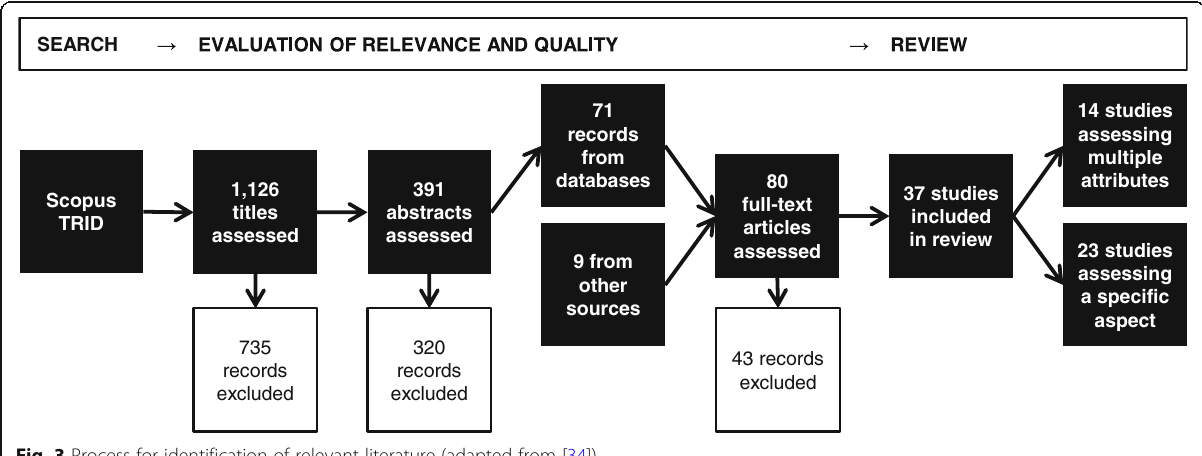
Fig. 3 Process for identification of relevant literature (adapted from [34])